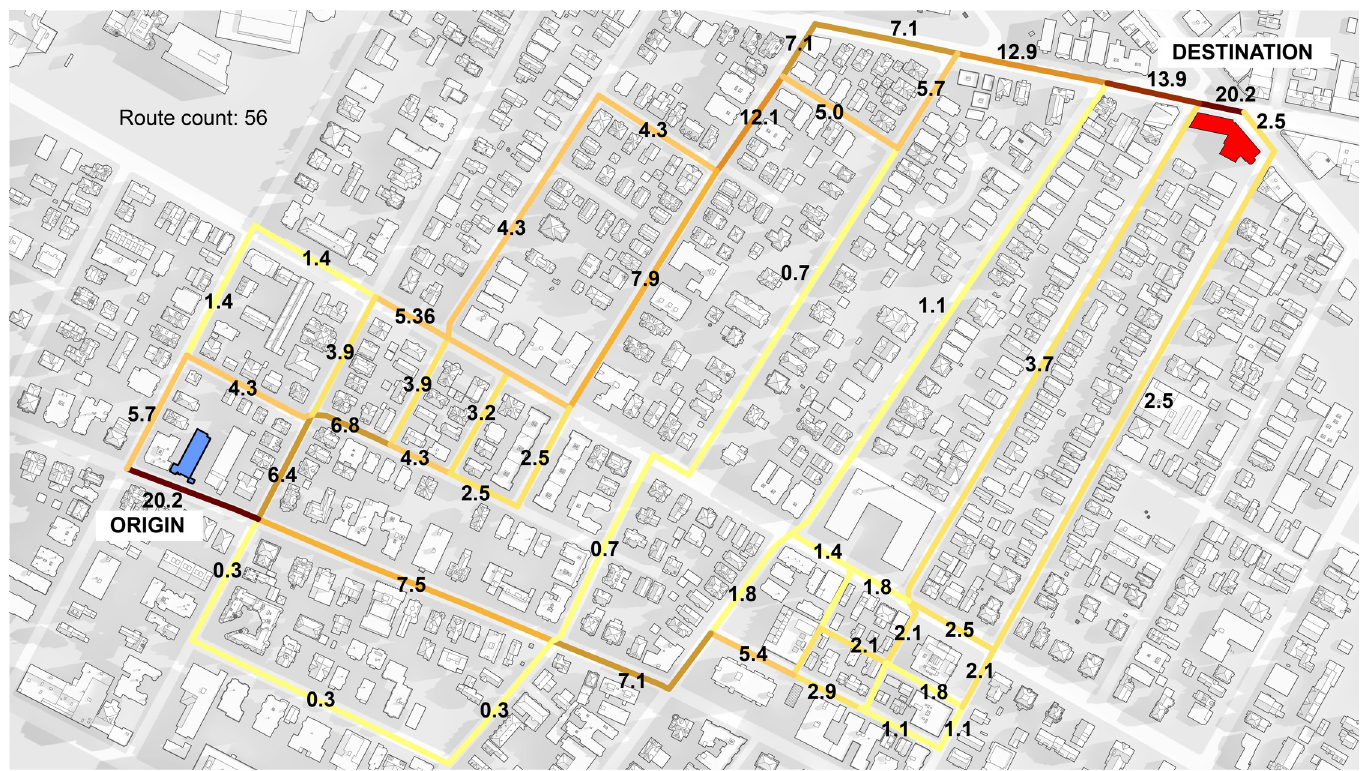
Fig 2. Betweenness results for street segments for a single origin-destination pair, where the origin has a weight of “100” (of which only 20.2 are routed due to a distance decay effect) along all routes that are up to 15% longer than the shortest path. data on dominant trip generation types during morning and evening peak periods in the US context [58] and discussed dominant trip types with planners in Melbourne, which led to a selection of ten potentially important origin-destination pairs for our model, highlighted in gray in Fig 3. Patronage betweenness models were calculated using a maximum search radius of 800m, since the median pedestrian trip length in Melbourne’s inner suburbs is 563m and